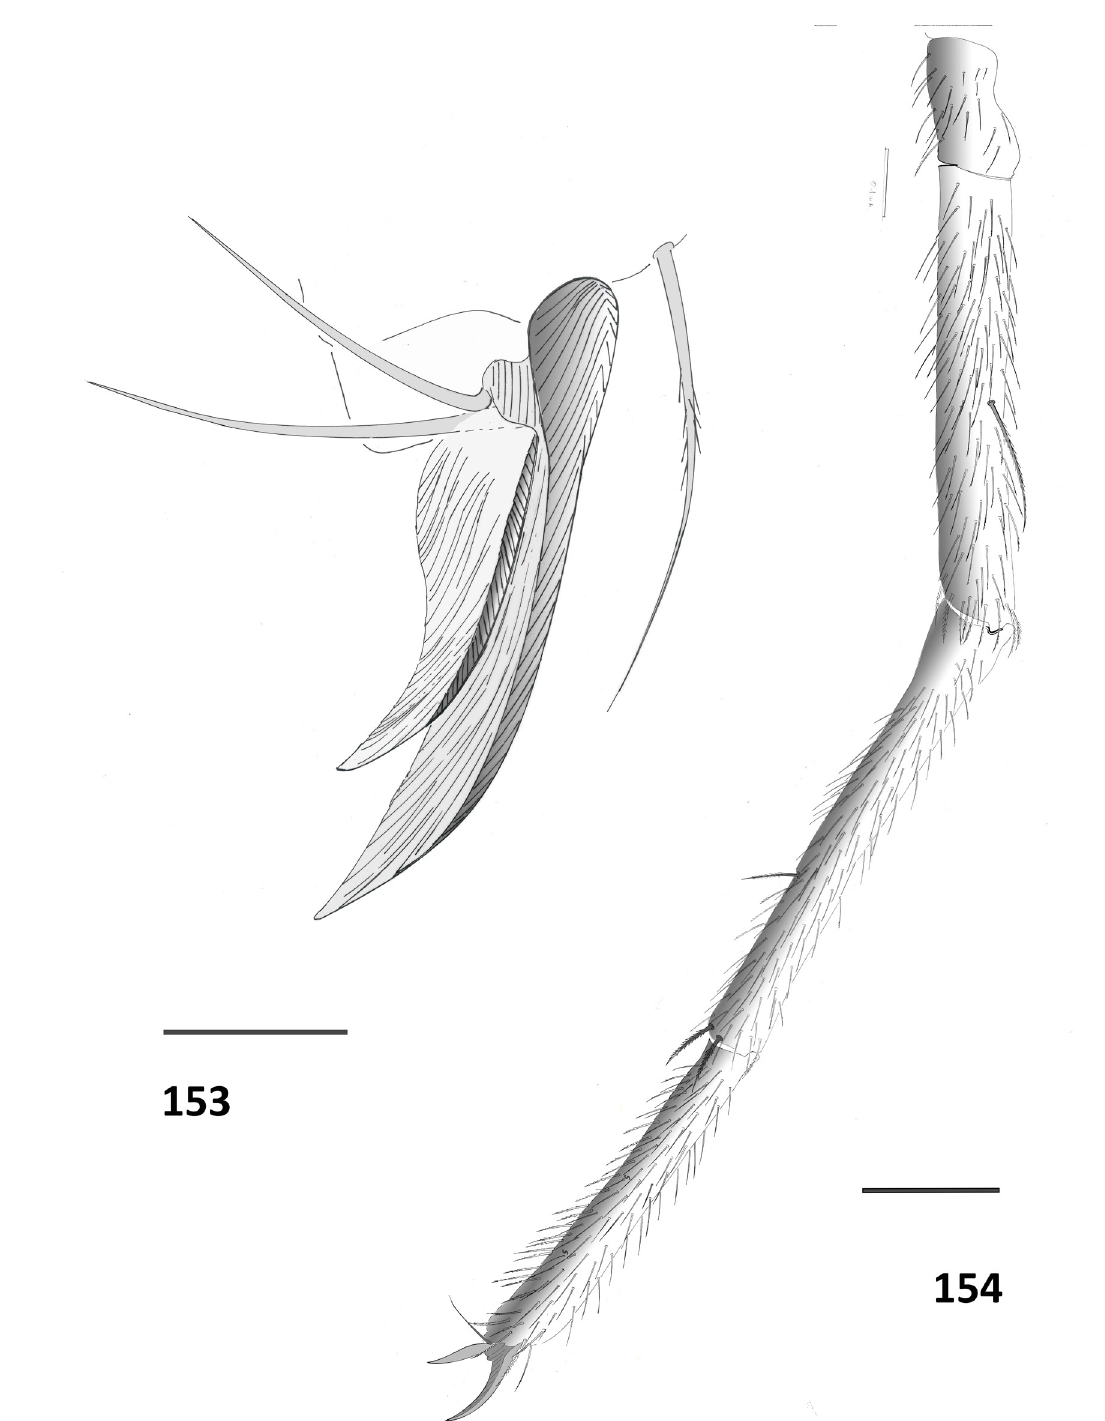
Figs 153–154. Plusiocampa ( Plusiocampa ) ternovensis Sendra & Borko sp. nov., paratype, ♀, 4.4 mm long, from Velika ledena jama v Paradani, Predmeja, Slovenia (PMSL Diplura-003). 153 . Metathoracic leg. 154 . Metathoracic pretarsus, lateral anterior side. Scale bars: 153 = 100 μm; 154 = 50